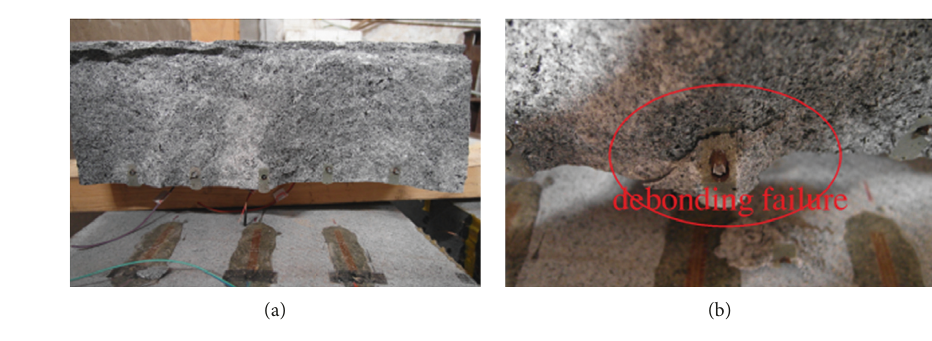
Figure 19: Failure mode of